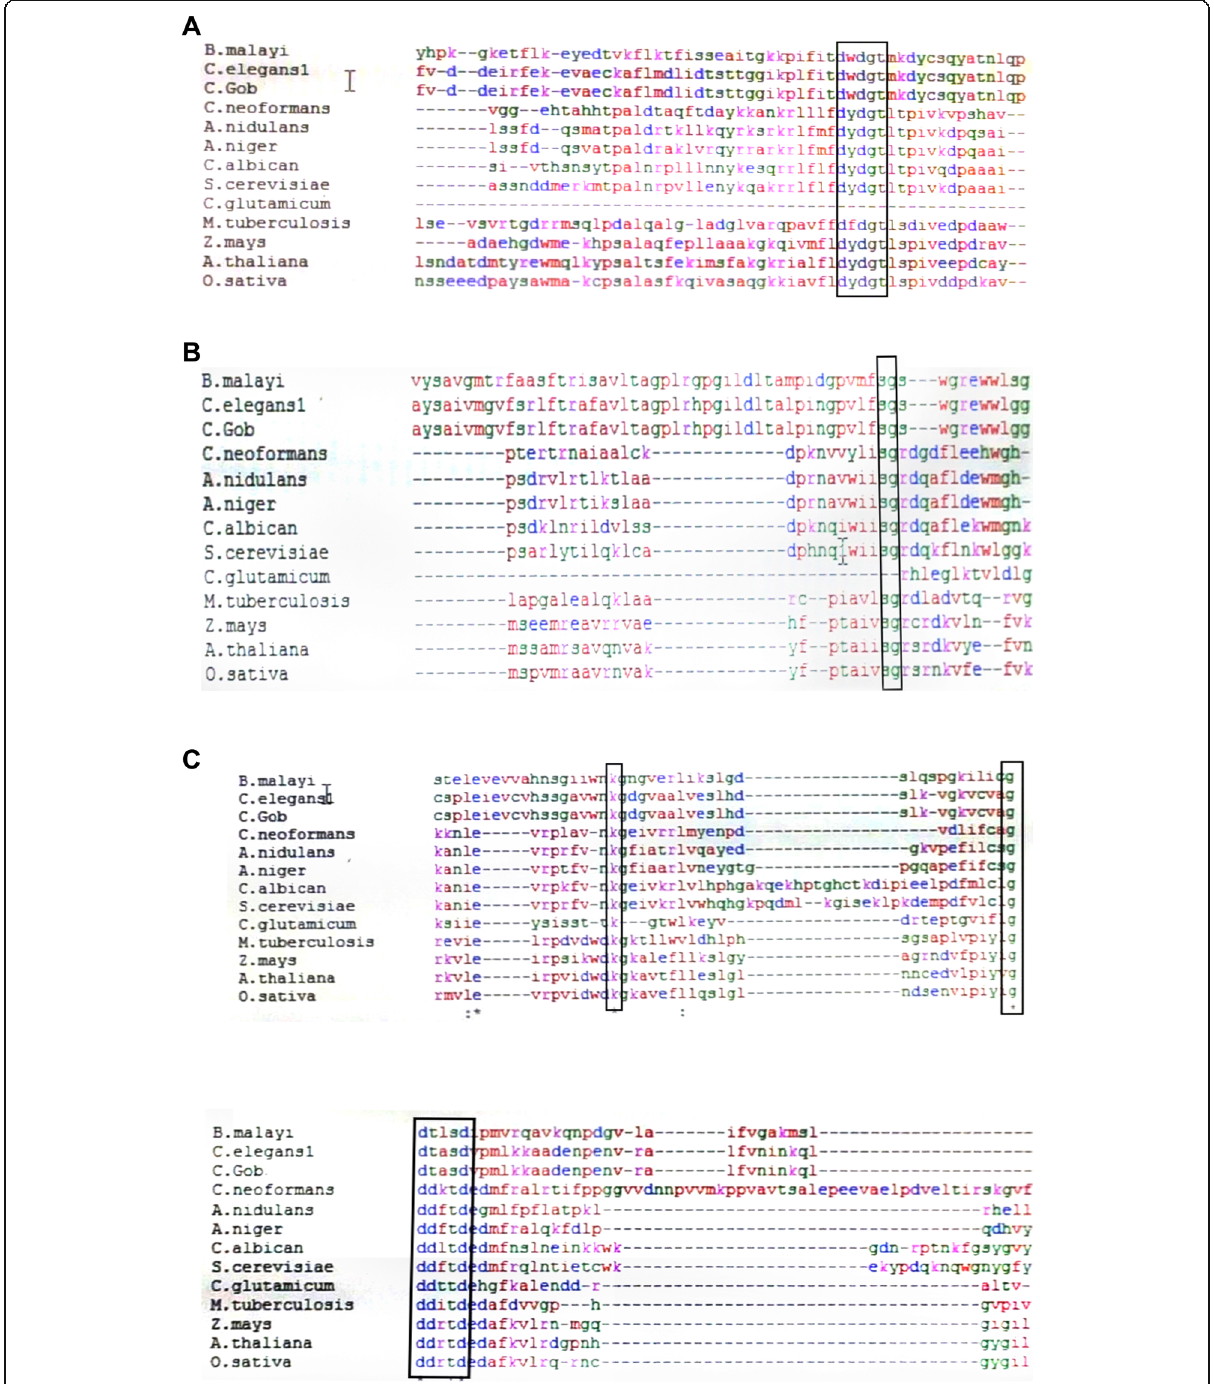
Fig. 1 a Region 1 of conserved amino acid sequences of TPP proteins. b Region 2 of conserved amino acid sequences of TPP proteins. c Region 3 of conserved amino acid sequences of TPP